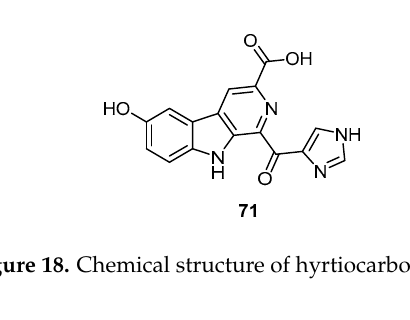
Figure 18. Chemical structure of hyrtiocarboline ( 71 ).